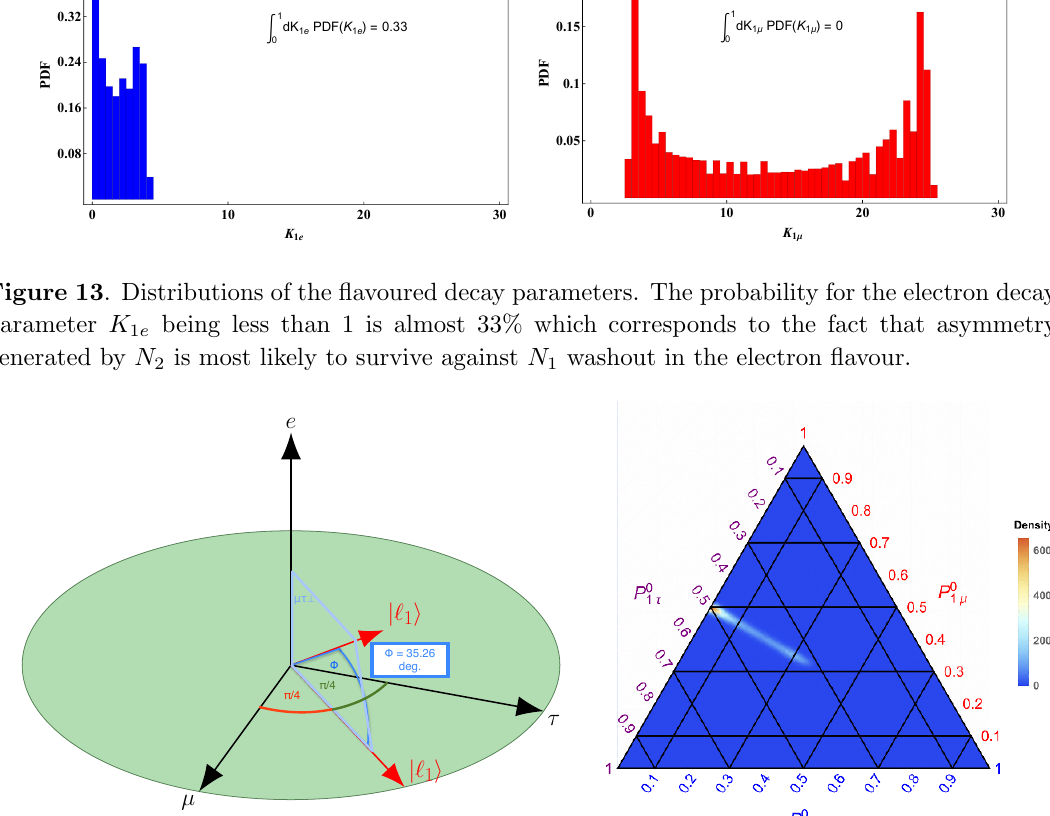
‘ in the CP symmetric model j i 1